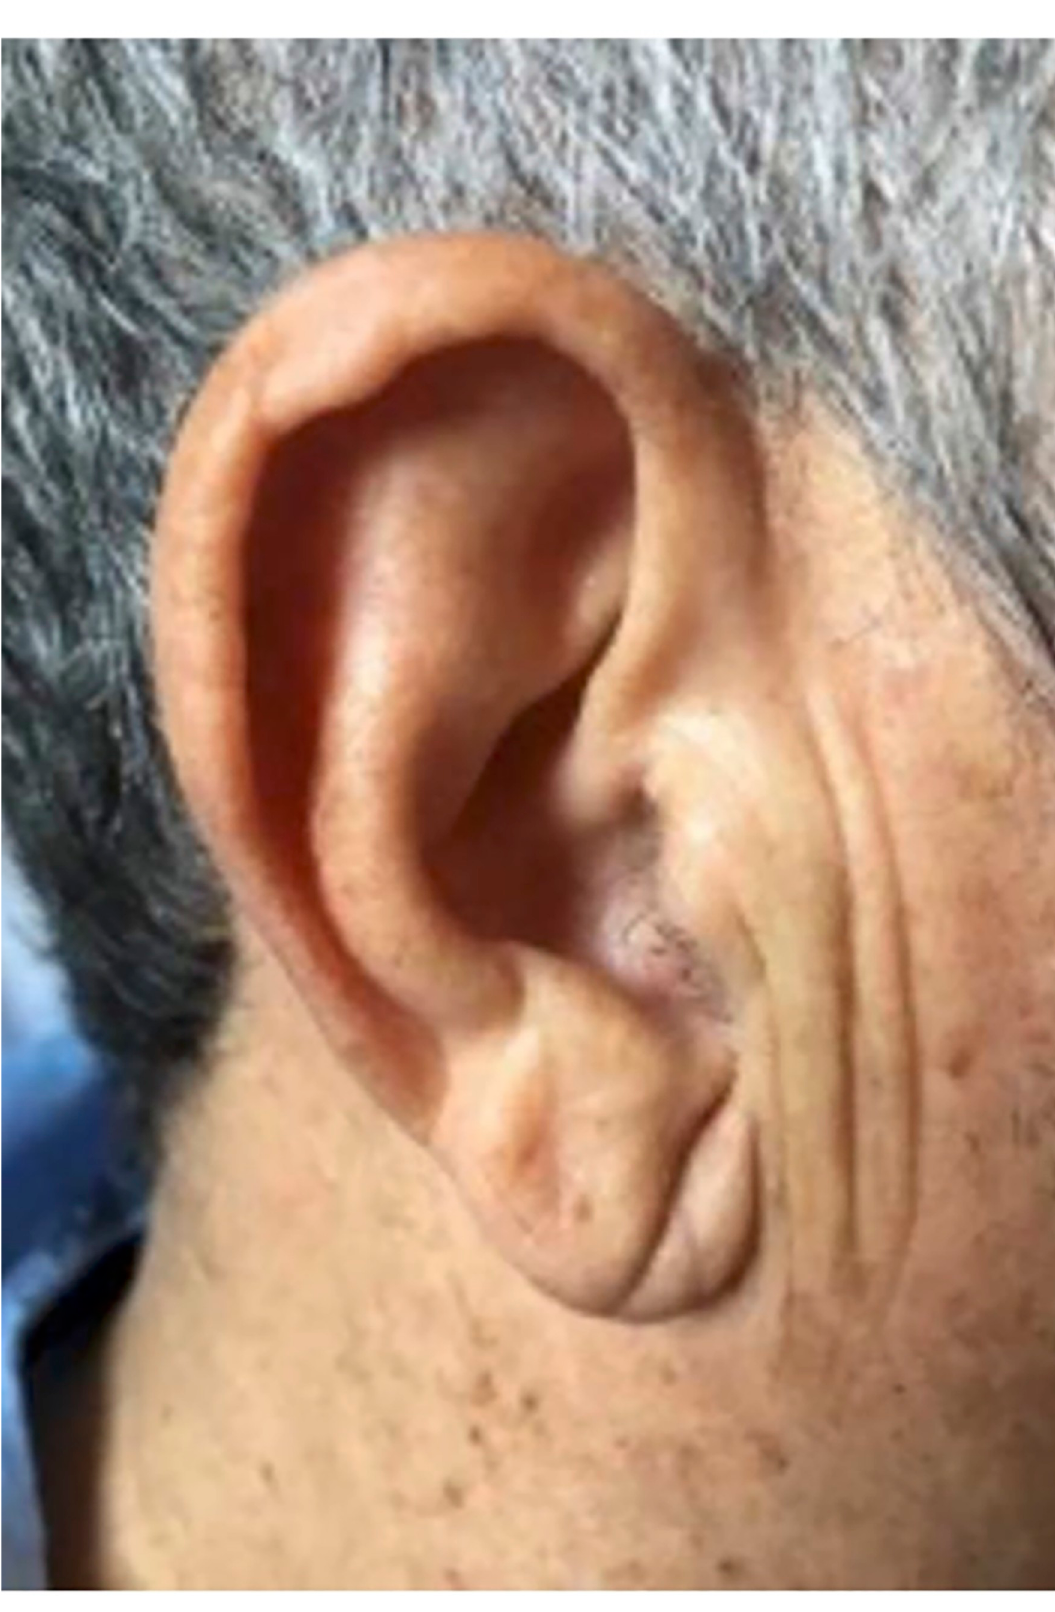
Fig 1. The Frank’s sign. Diagonal earlobe